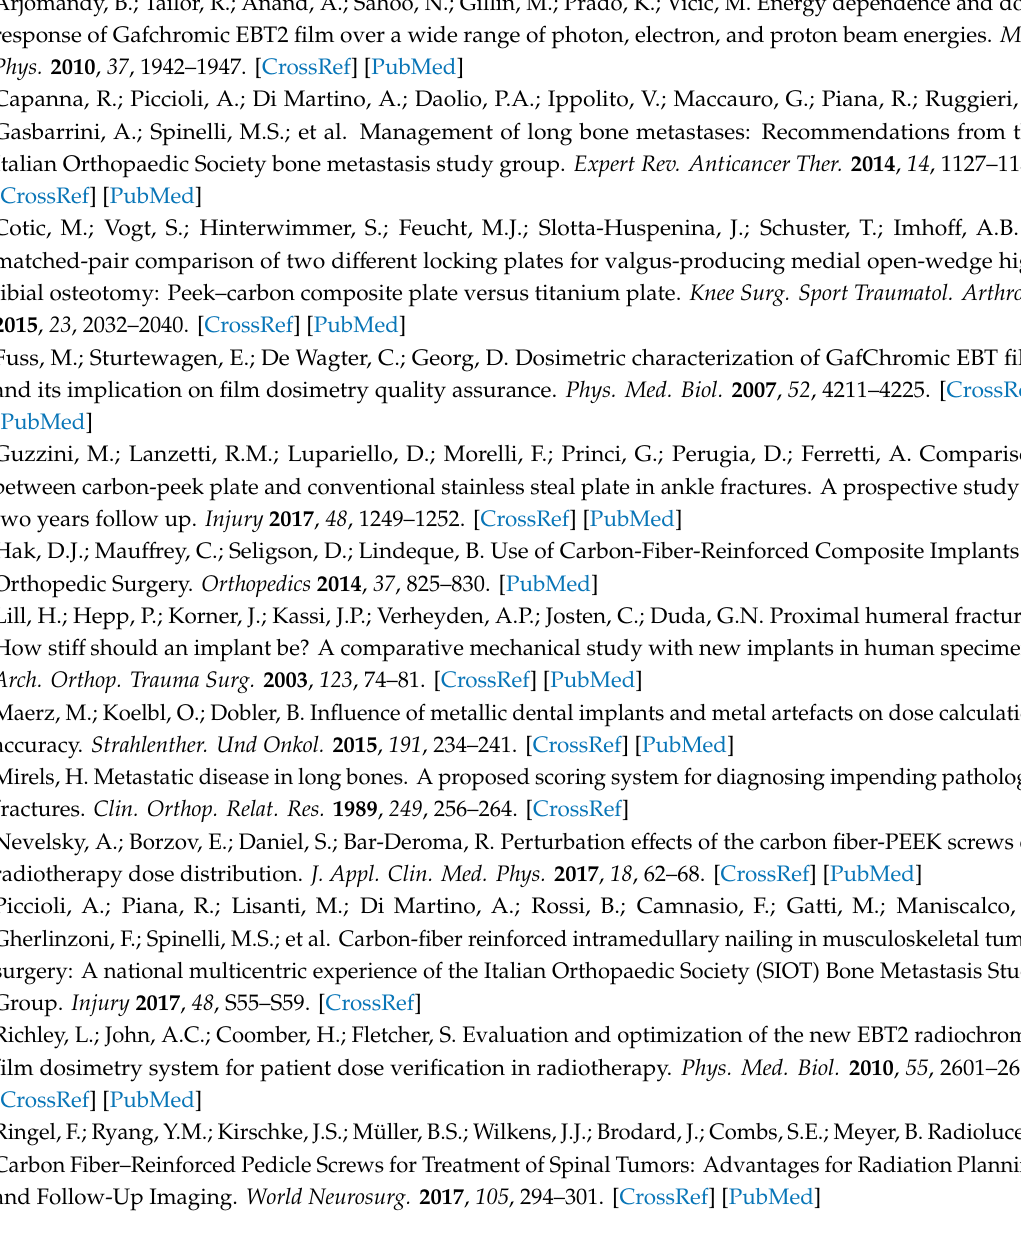
Figure S1: Measured dose deviation with reference to the normalized dose in the periphery. Ti: Titanium; SD: Standard